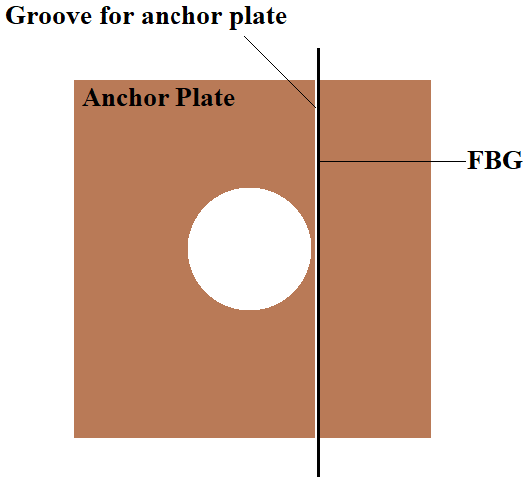
Figure 7. FBG sensor installed on Anchor